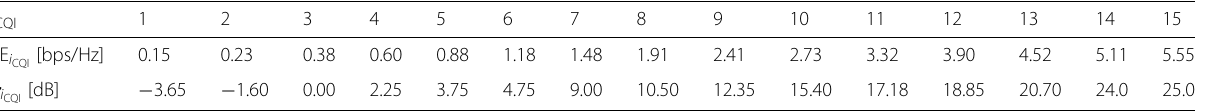
Table 2 SINR thresholds and SE values obtained from the LTE link-level simulator in [9, 10] i